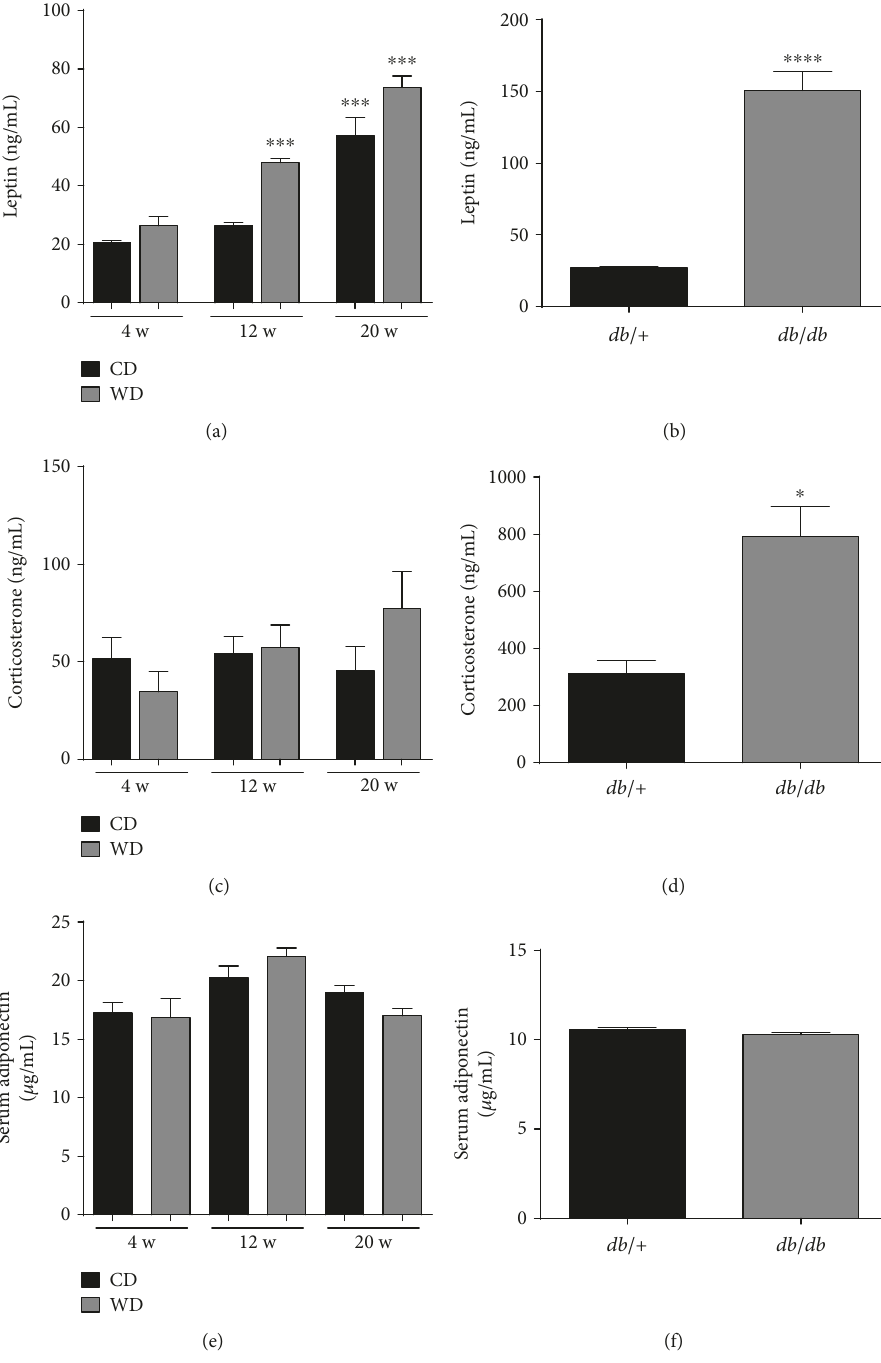
Figure 4: Elevated corticosterone in serum of db/db mice but not WD-fed mice. Serum levels of leptin (a, b), corticosterone (c, d), and adiponectin (e, f) in C57BL/6J mice fed either control or Western diet for 4, 12, and 20 weeks (a, c, e) or 14-week-old db /+ and db / db mice (b, d, f). n = 8 per group; means ± SEM. ∗∗∗∗ p < 0 0001 ; ∗∗∗ p < 0 001 ; ∗ p < 0 05 . CD: control diet; WD: Western diet;